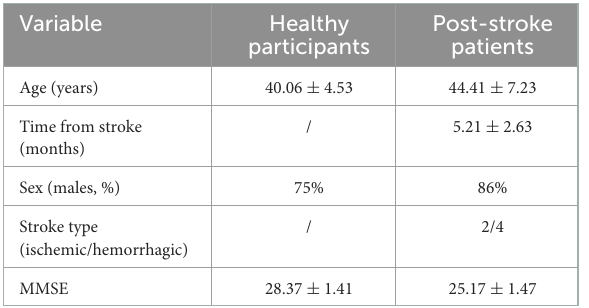
TABLE 1 Basic data of